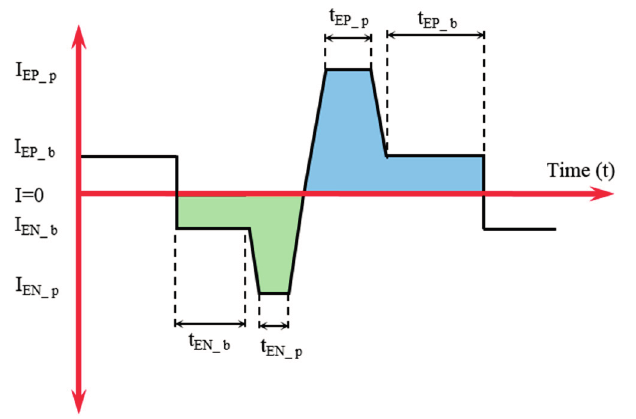
Figure 1. Schematics of the improved current waveform.